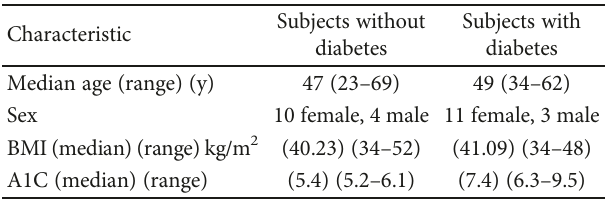
Table 1: Clinical characteristics of the nondiabetic and diabetic patients. Characteristic